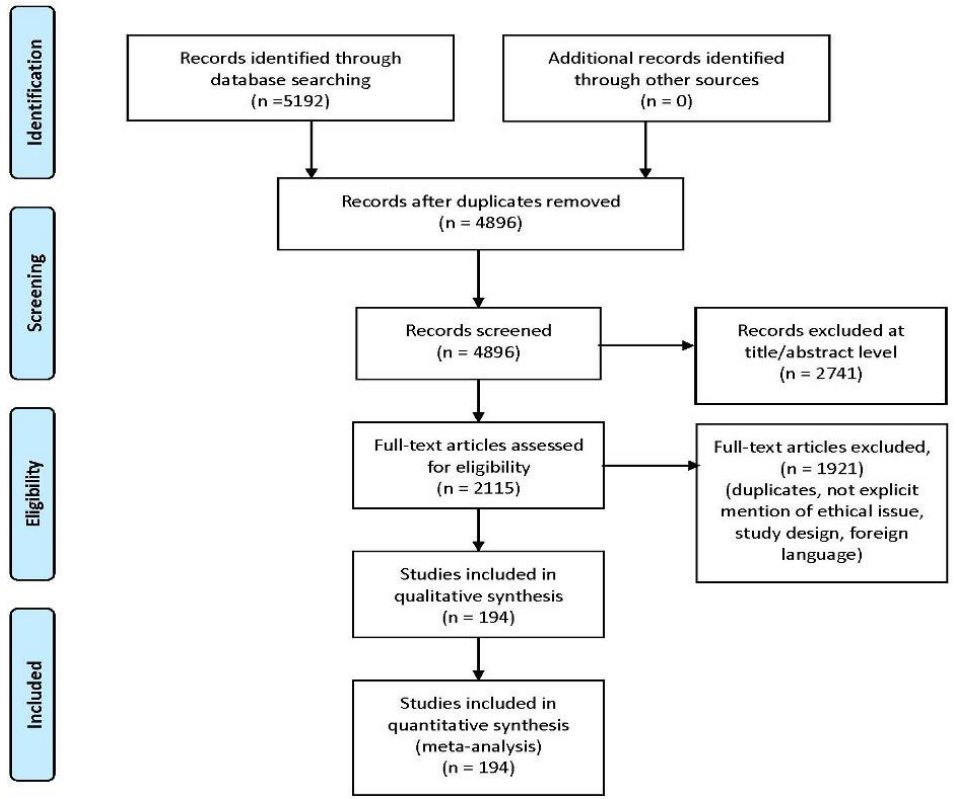
Figure 1. Preferred Reporting Items for Systematic Review (PRISMA) flow chart — search strategy.